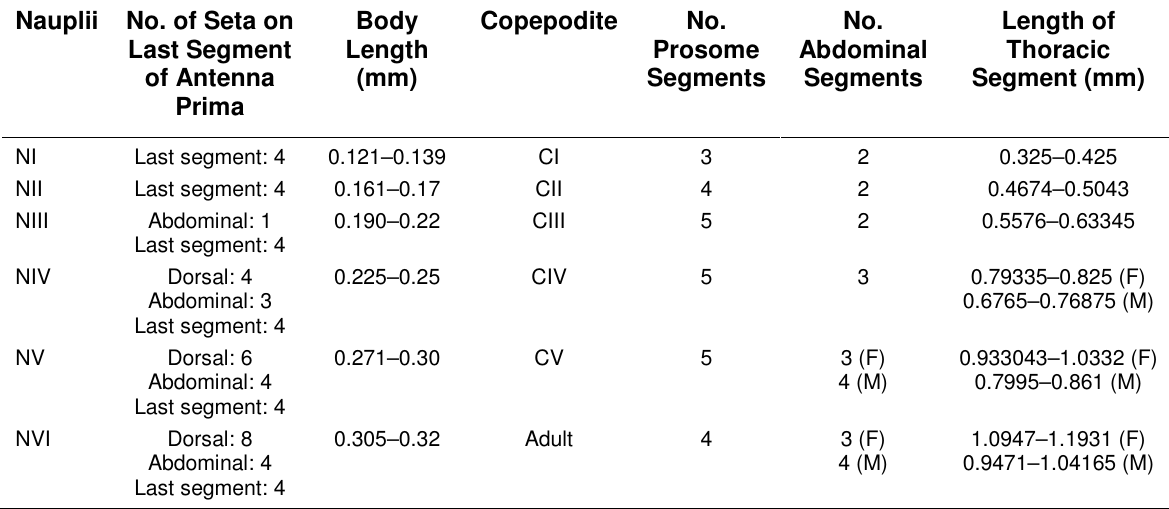
Main Characteristics of Each Stage of Nauplii and Copepodites of P.